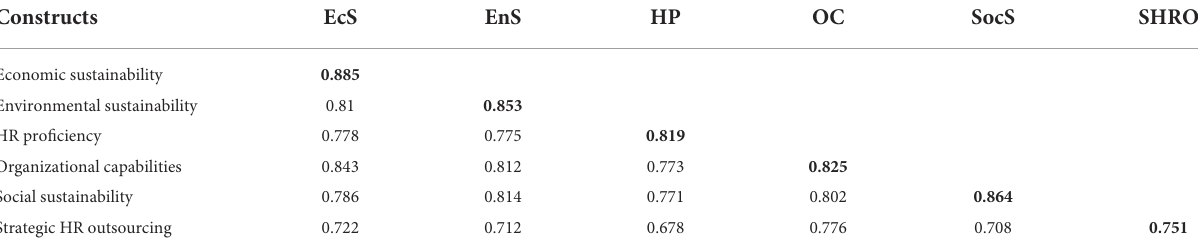
TABLE 5 Discriminant validity (fronell and larcker